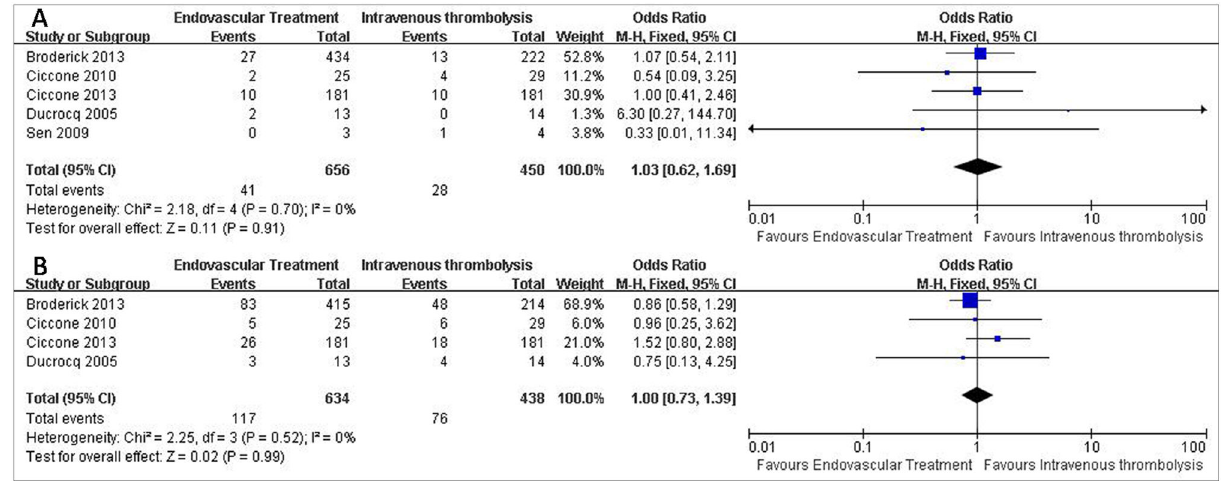
Figure 3. Secondary Outcomes of patients treated with Endovascular Therapy and Intravenous Thrombolysis after acute ischemic stroke. (A) Forest plot of RR and 95% CI for the occurrence of symptomatic hemorrhage in patients assigned to Endovascular Therapy and Intravenous Thrombolysis. (B) Forest plot of RR and 95% CI for the occurrence of mortality in patients assigned to Endovascular Therapy and Intravenous